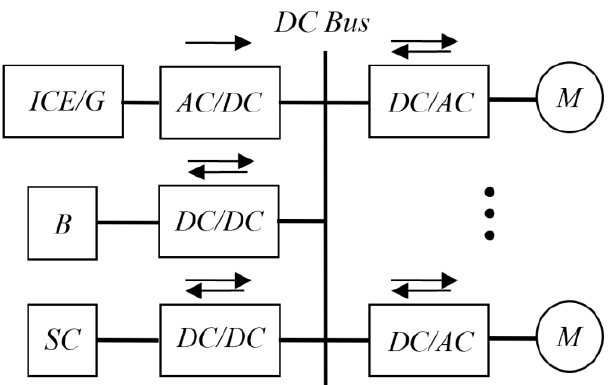
Figure 2. Combined 4WD vehicle system with ICE/G as main power source.